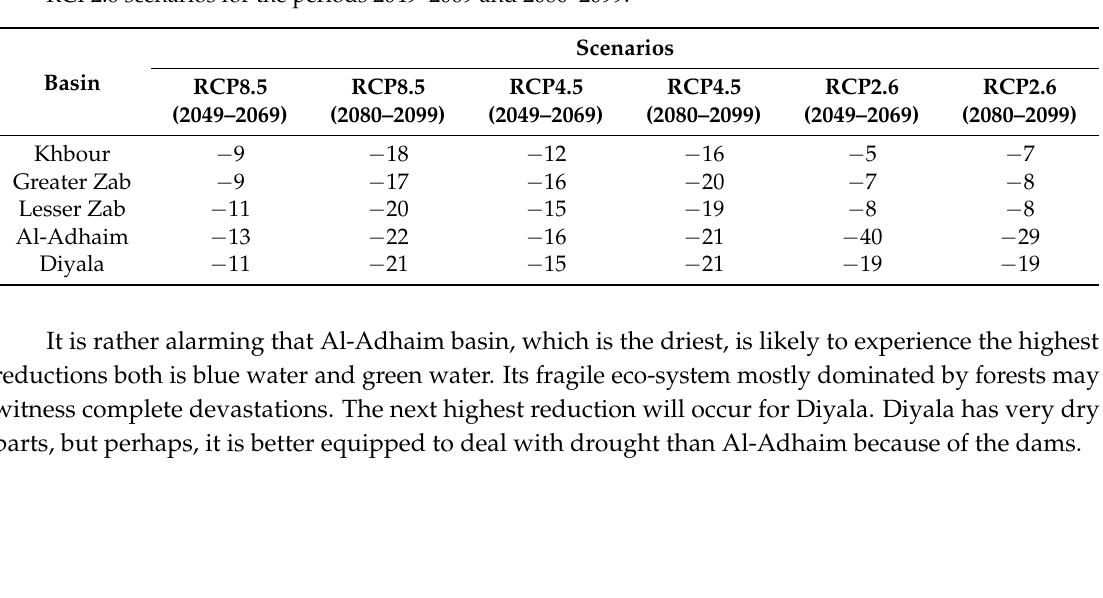
Table 8. The projected relative changes in green water for the five basins under RCP8.5, RCP4.5,